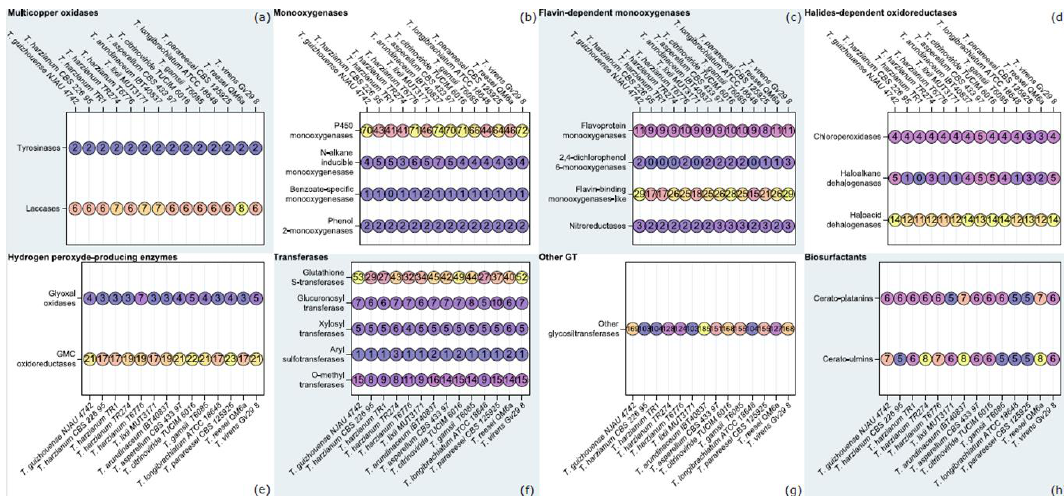
Figure 1. Degradative potential of Trichoderma species, compared with Trichoderma lixii MUT3171: Comparative genome analysis of T. lixii MUT3171, and 14 sequenced Trichoderma species (more details are provided in Table S2) in order to investigate well-supported enzymatic categories involved in the degradation of pollutants [44]. In each box and for each species, the number of orthologs of a specific enzyme class is reported.